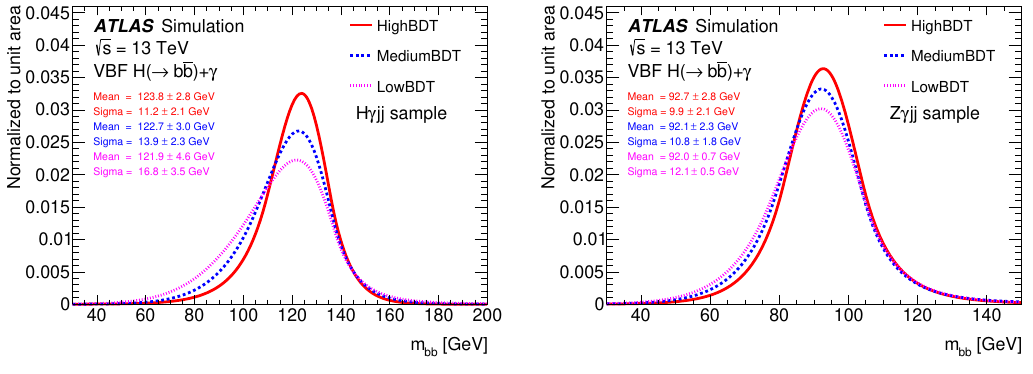
Figure 4 . Comparison of the Bukin function parameterizations, normalized to unit area, of the m bb distributions for H(cid:13)jj events (left) and Z(cid:13)jj events (right) in the three BDT categories, along with the mean and sigma values for the three (cid:12)tted